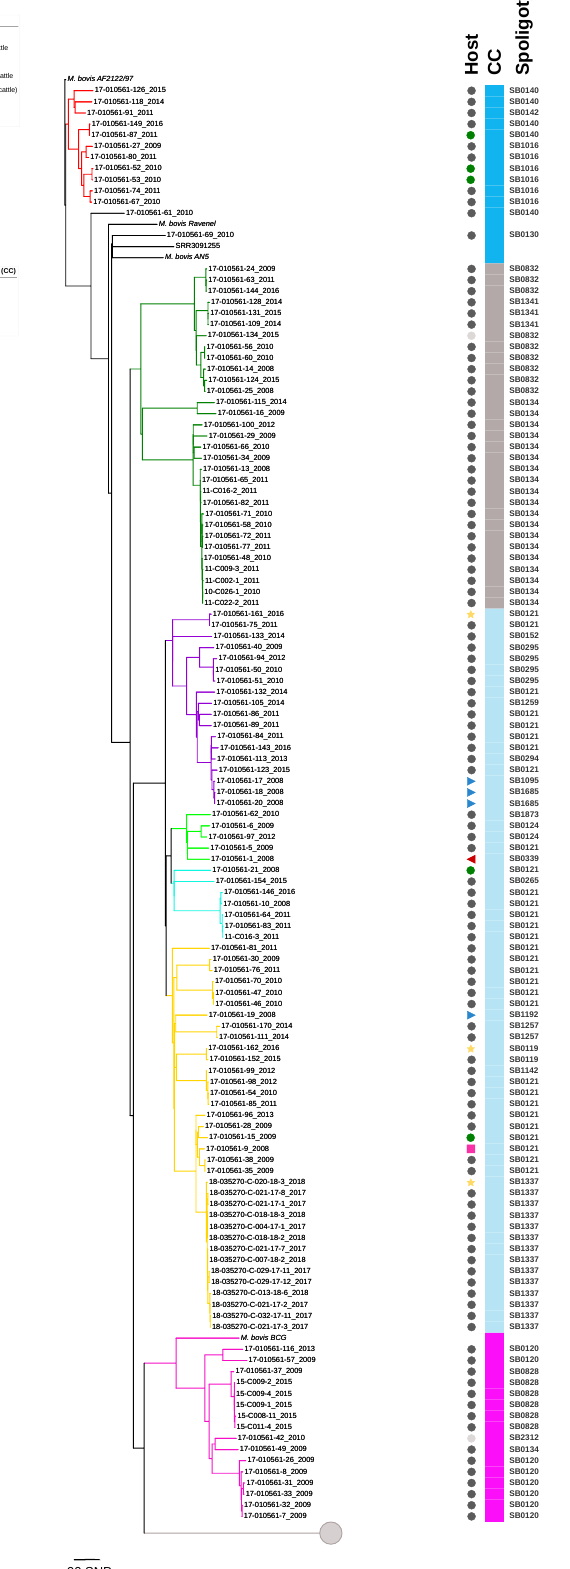
Figure 2. High-resolution maximum-likelihood phylogenetic tree including 125 M. bovis and 52 M. caprae isolates recovered from livestock and wildlife in Catalonia, Spain, between 2008 and 2018. Clades, clonal complexes, and host type are identified according to the legend. Isolate tags